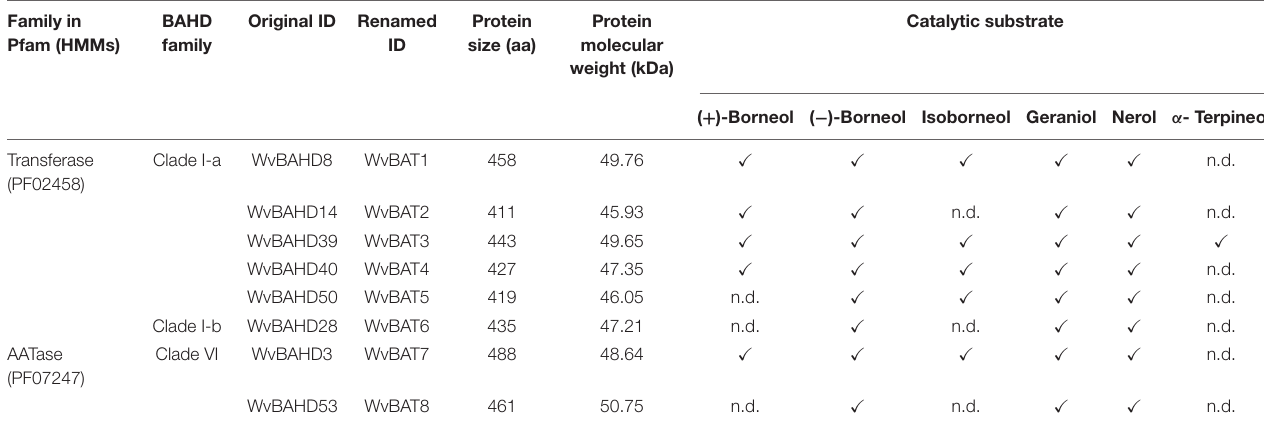
TABLE 1 | The information of the characterized WvBATs in Wurfbainia Villosa . Family in Pfam